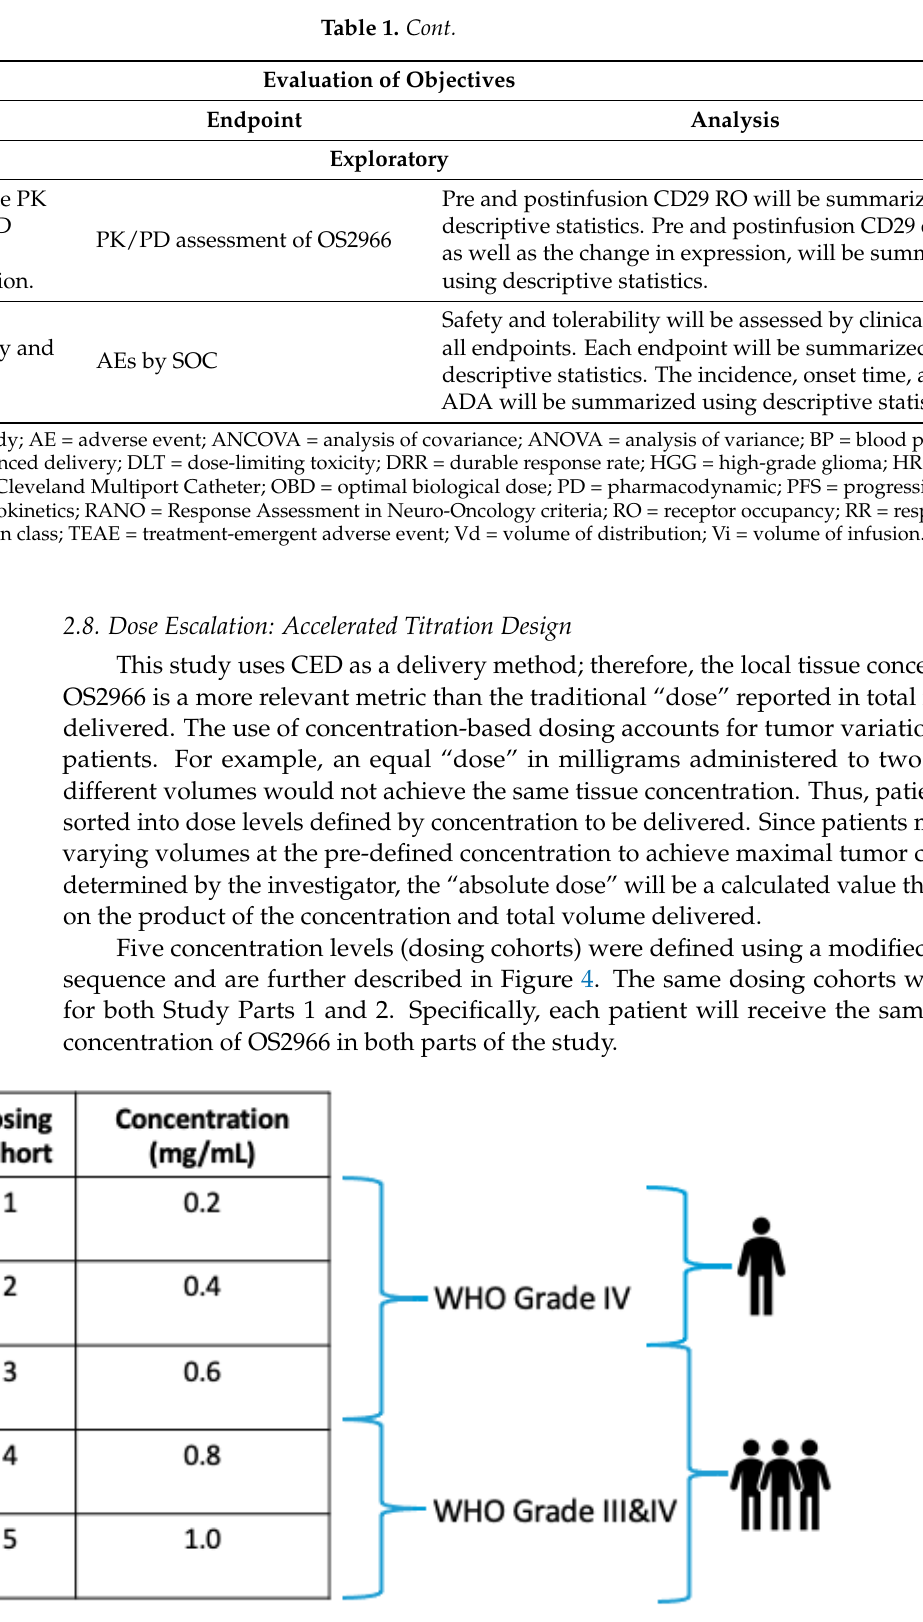
Figure 4. Dose escalation will be conducted at five pre-determined concentration levels. The first two dosing cohorts will enroll one patient each. Starting at the third dose level, the study will convert into a “3 + 3” design, in which three patients will be enrolled into each dosing cohort. If any qualifying adverse events (AEs) or dose-limiting toxicity (DLTs) occur in the first two cohorts, the study will automatically convert to “3 + 3” at that dose level.